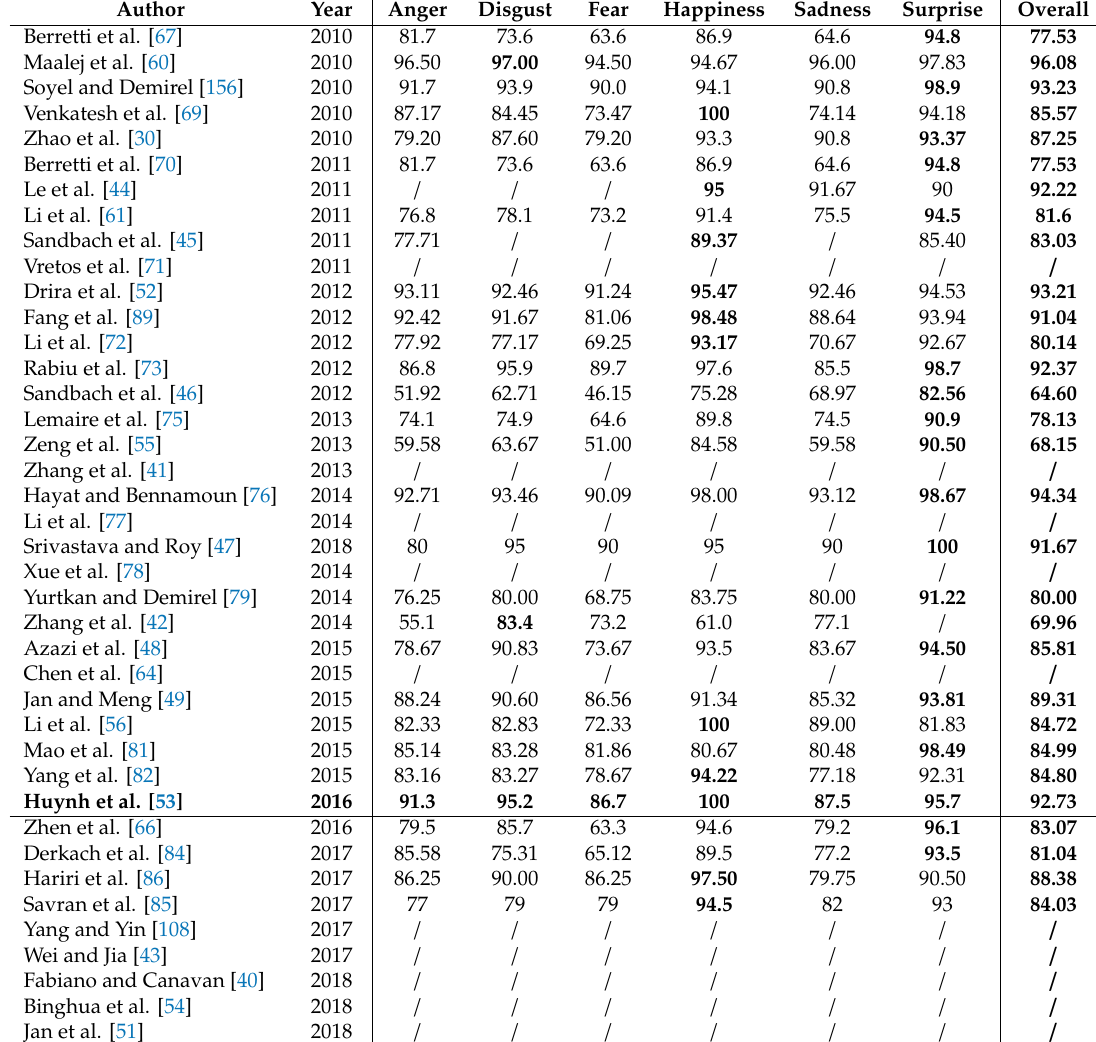
Table 5. Recognition rates (RRs) in the presence of each type of facial expression and the overall average result obtained. For every kind of emotion, the best result is written in bold